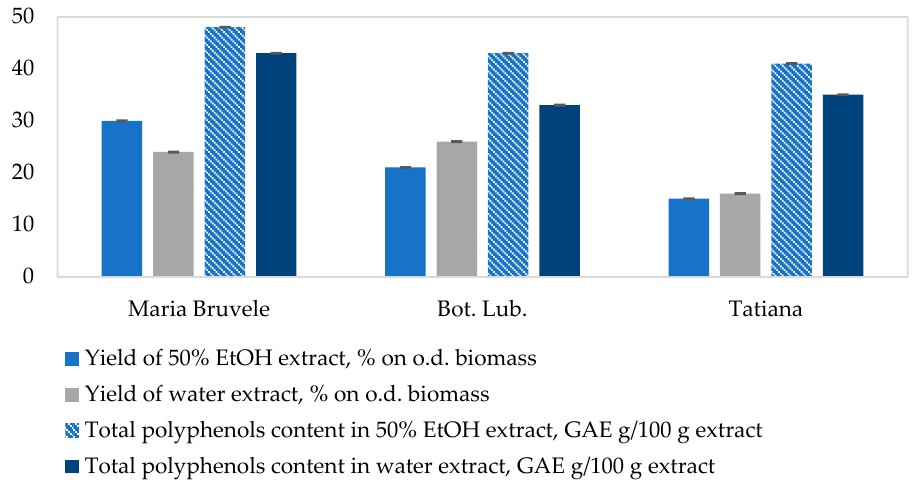
Figure 2. Effect of the extractants on the extract yield from twigs of SBT and selectivity for polyphe- nolic compounds (single-step extraction, 30 min, 60 °C, biomass and extractant weight ratio 1:8). Data represented as mean ± SD ( n = 3).